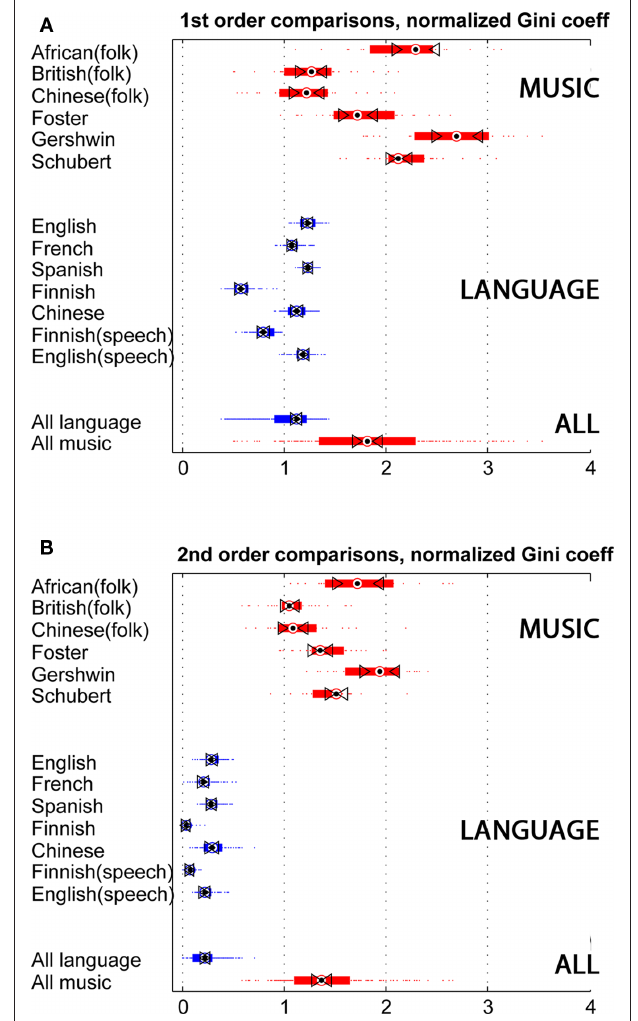
FIguRe 2 | Sparseness in music and language examples, as measured by the gini coefficient (normalized in comparison to statistically similar random surrogate data). Red: 194 melodies from six traditions; Blue: 700 texts, written, and transcribed. Colored bars span the 25th to the 75th percentile. Triangle markers span the 95% confidence interval. The bottommost bars represent aggregate medians in the two groups. (A) 1st order sparseness, i.e., sparsity/density of single symbols (words or tones). (B) 2nd order sparseness, i.e., sparsity/density of sequential pairs of symbols. Overall, the figure points to a robust and large difference in first- and especially second-order sparseness, as measured by the